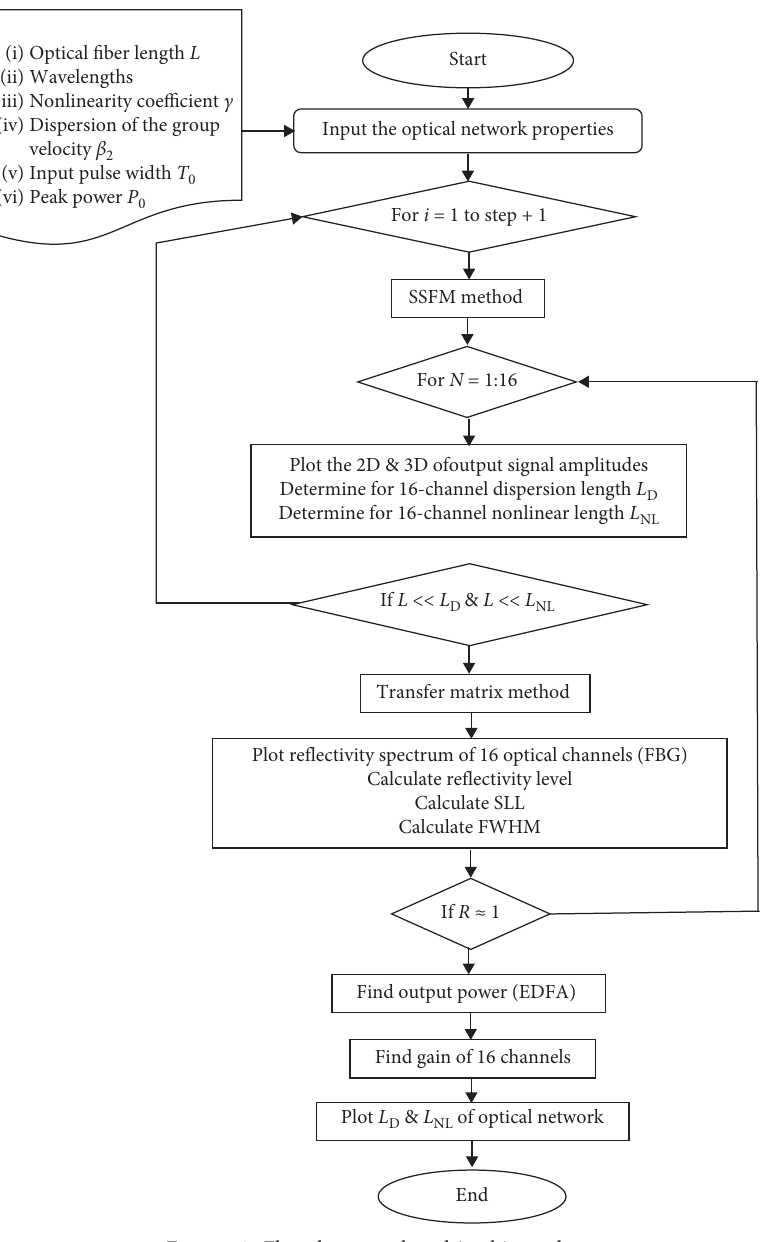
Figure 3: Flowchart employed in this study.